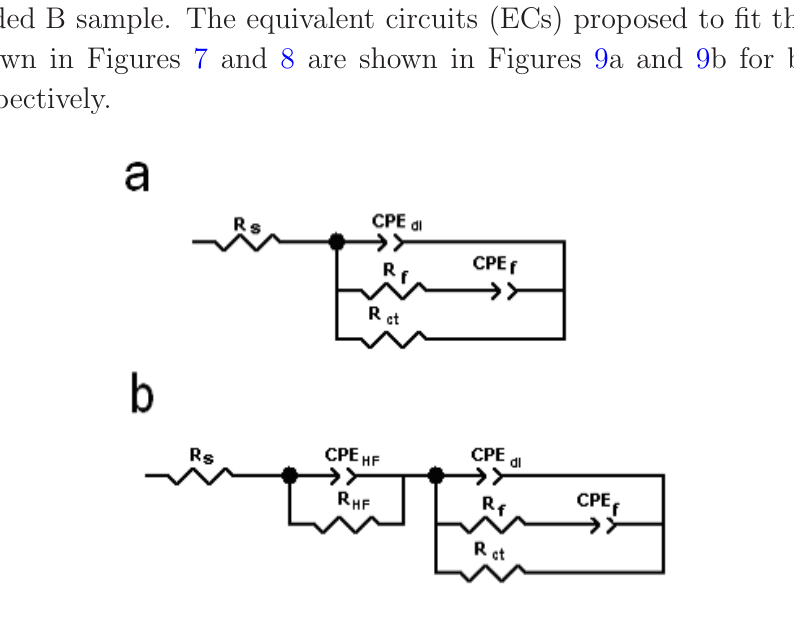
Fig. 9 Equivalent circuits corresponding to the CNLS calculation of impedance spec- tra of Figure 7 and 8: (a) Fe-Ni-Cr electrodeposit, sample A after 18 h corrosion at E . 086 V (b) Fe-Ni-Cr electrodeposit, sample B after 18 h wet and 18 h dry cor- corr = – 0 rosion cycle followed the SWPC treatment, at E corr = –0.312 V. The physical meanings of the elements are described in the